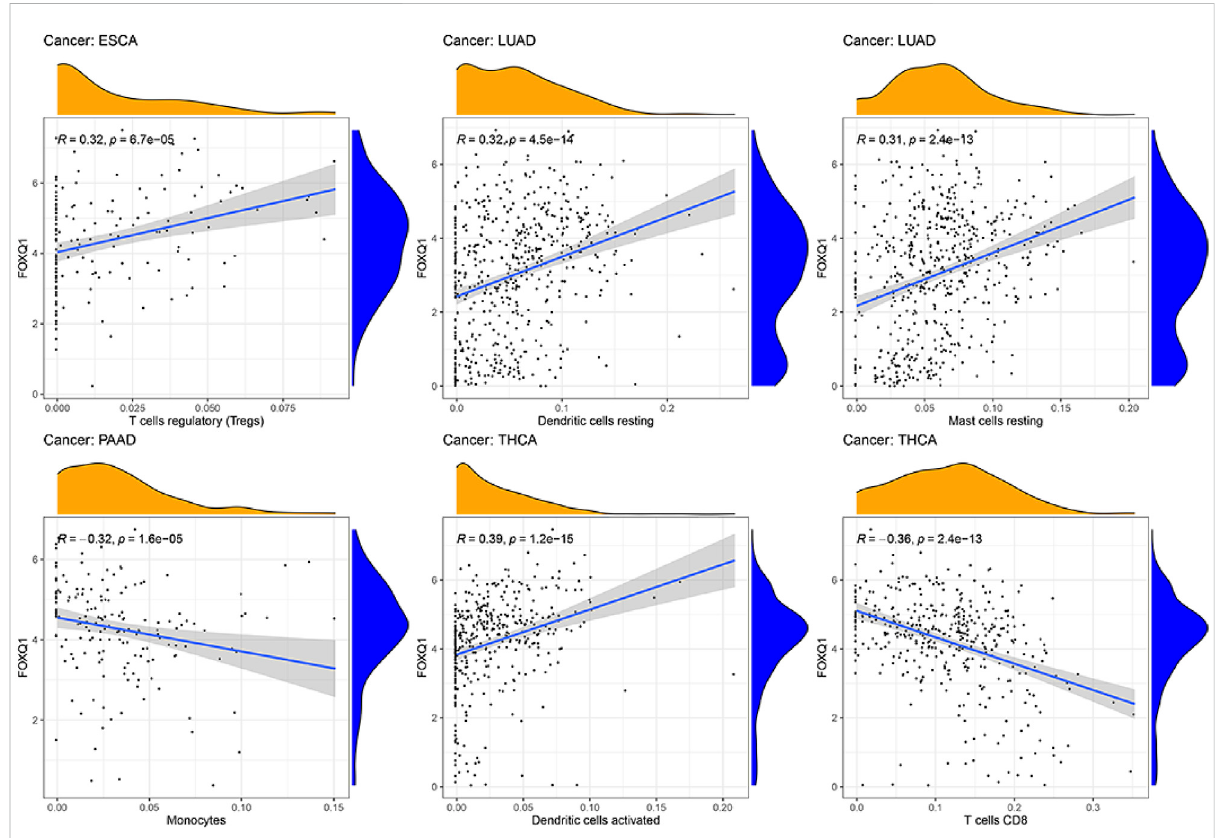
FIGURE 10 Correlation of forkhead box Q1 expression with immune cell in fi ltration in esophageal carcinoma, lung adenocarcinoma, pancreatic adenocarcinoma, and thyroid